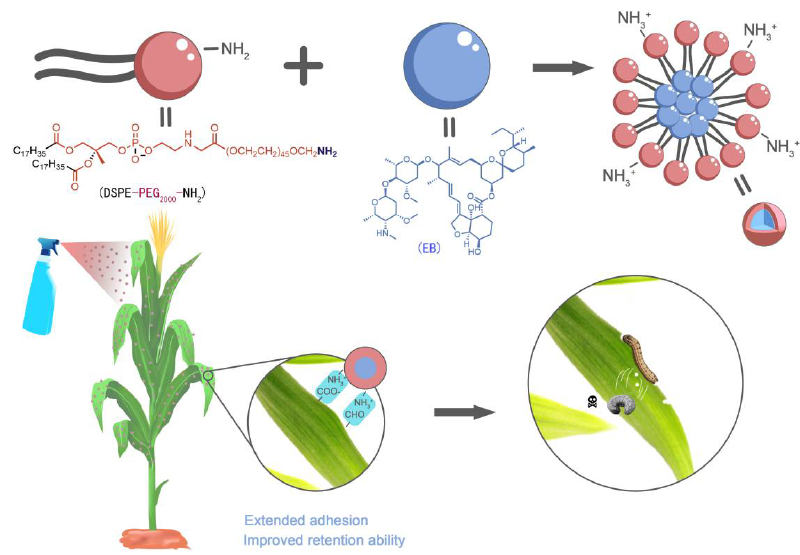
Scheme 1. Schematic illustration of the preparation of DSPE-EB nanoparticles and their application for S. frugiperda